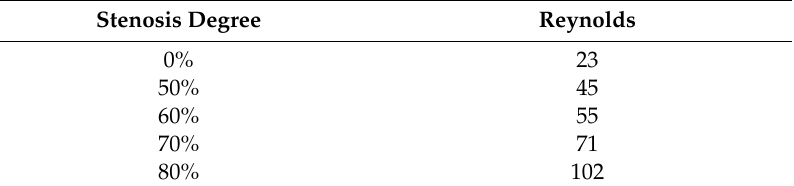
Table 1. Reynolds number at the stenotic section for the di ff erent degrees of stenosis.